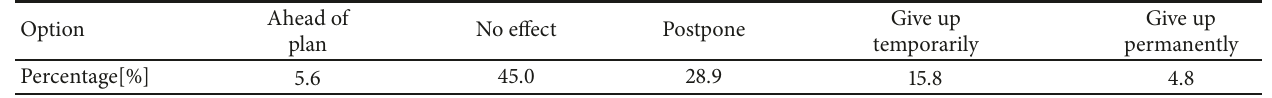
Table 9: Change of car purchase plan after joining car-sharing.